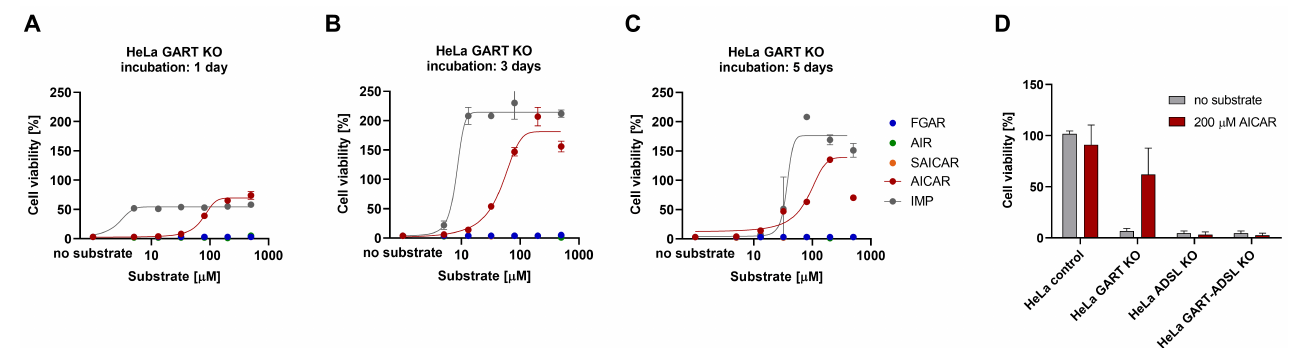
Figure 4. AICAR restores the viability of HeLa GART KO cells. The viability of HeLa GART KO cells was measured after ( A ) 1 day of incubation, ( B ) 3 days of incubation, ( C ) 5 days of incubation in purine-depleted medium with FGAR (blue), AIR (green), SAICAR (orange), AICAR (red), IMP (grey) in concentration range from 5 µ mol/L to 500 µ mol/L. ( D ) HeLa control, GART KO, ADSL KO, GART-ADSL KO viability measurement after 72 h incubation in normal medium containing no metabolite (grey) or 200 µ M AICAR (red). Each data point represents the mean of 3 measurements. Vertical bars represent S.D. (n =